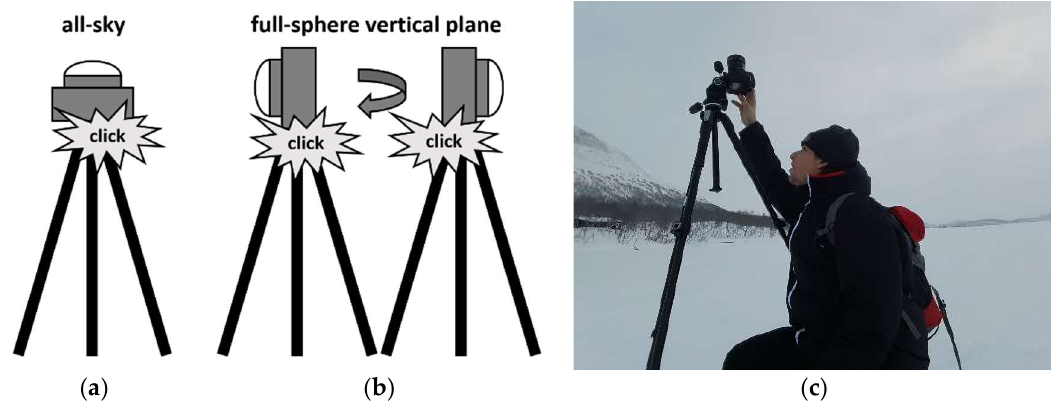
Figure 1. Operating the camera system ( a ) in all-sky mode, ( b ) in vertical 4pi mode and ( c ) during field work under harsh conditions (on Lake Kilpisjärvi, Finland, image by F. Hölker).